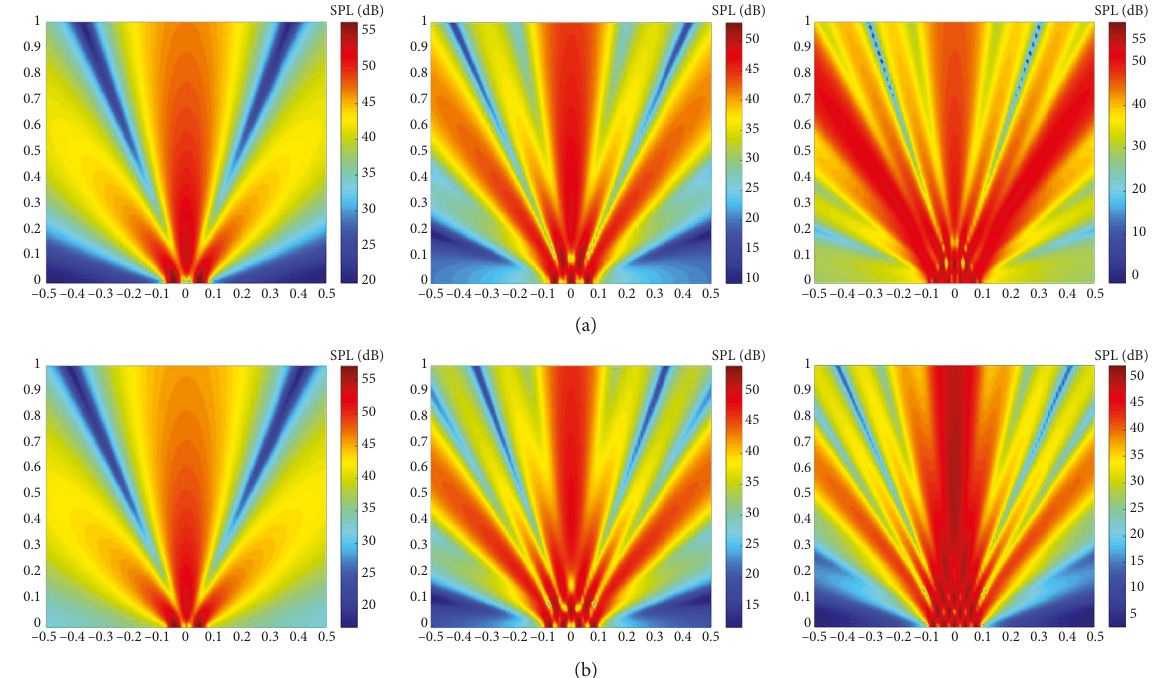
Figure 10: SPL distributions of the considered models: (a) model 3 and (b) model 5 at 500, 1000, and